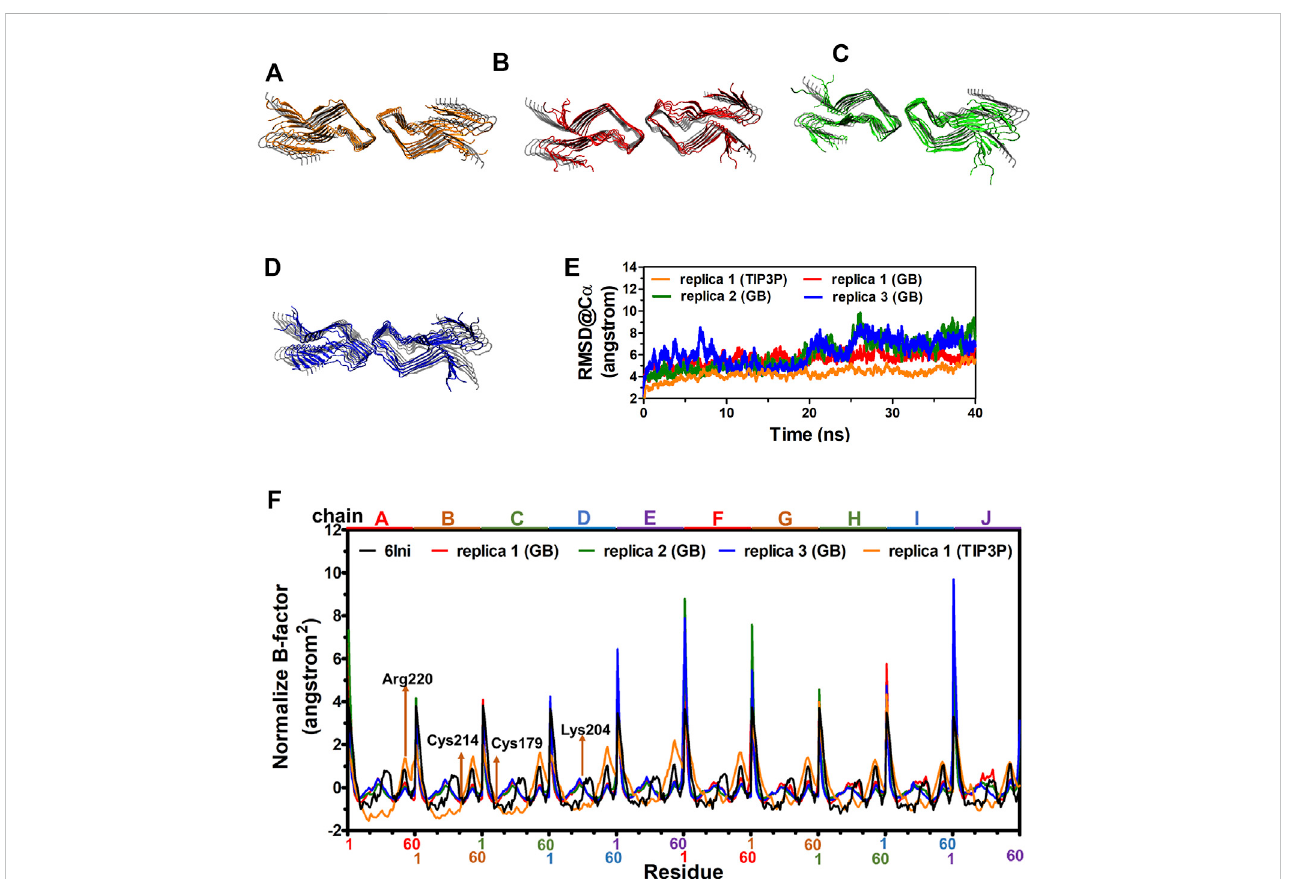
FIGURE 2 MD structures of fPrP 170 – 229 selected from the most populated clusters from three independent replica from explicit solvent model and implicit solvent model shown in (A) and (B – D) , respectively. The cryo-EM structure of fPrP 170 – 229 is shown in gray as a comparison. (E) The RMSD of fPrP 170 – 229 backbone in replica 1 from explicit solvent (TIP3P) and replica 1 – 3 from implicit solvent (GB). (F) Normalized B -factor from three fPrP 170 – 229 replica in implicit solvent and one replica in explicit